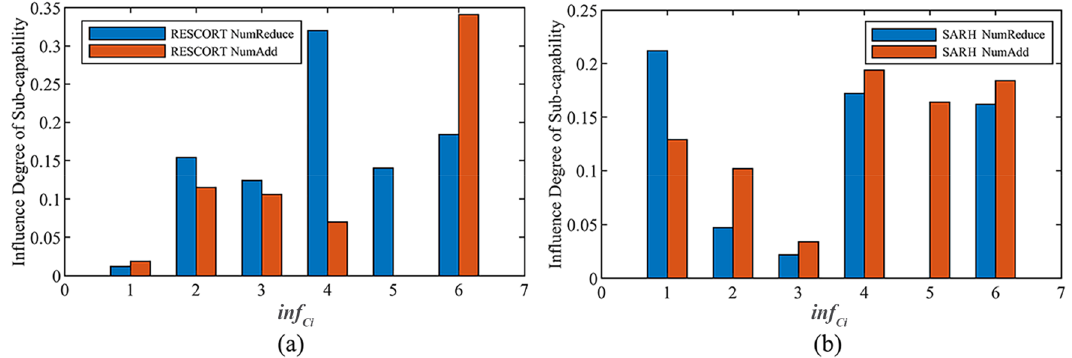
Figure 13. Extent to which the reduction and increase in the number of RESCORT or SARH affects each sub- capability: ( a ) RESCORT, ( b )